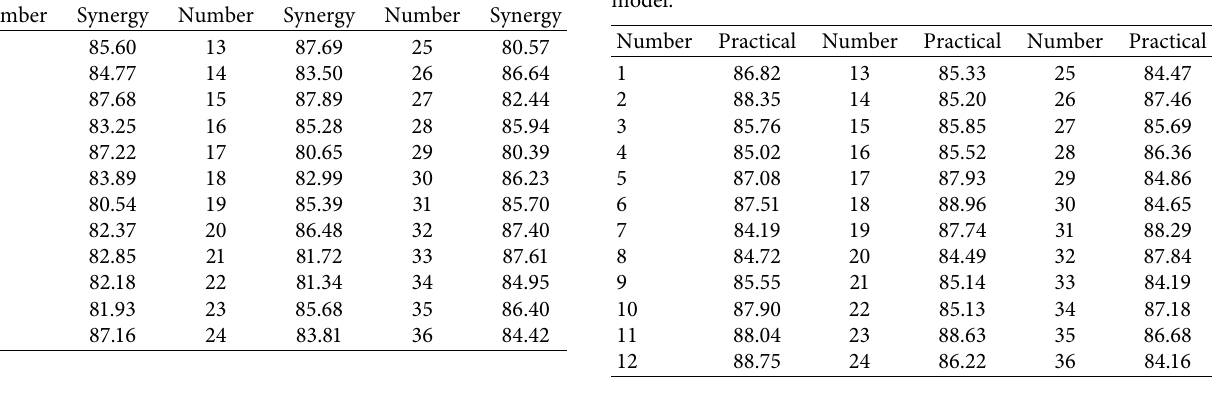
Table 2: Practical effects of e-commerce logistics collaboration